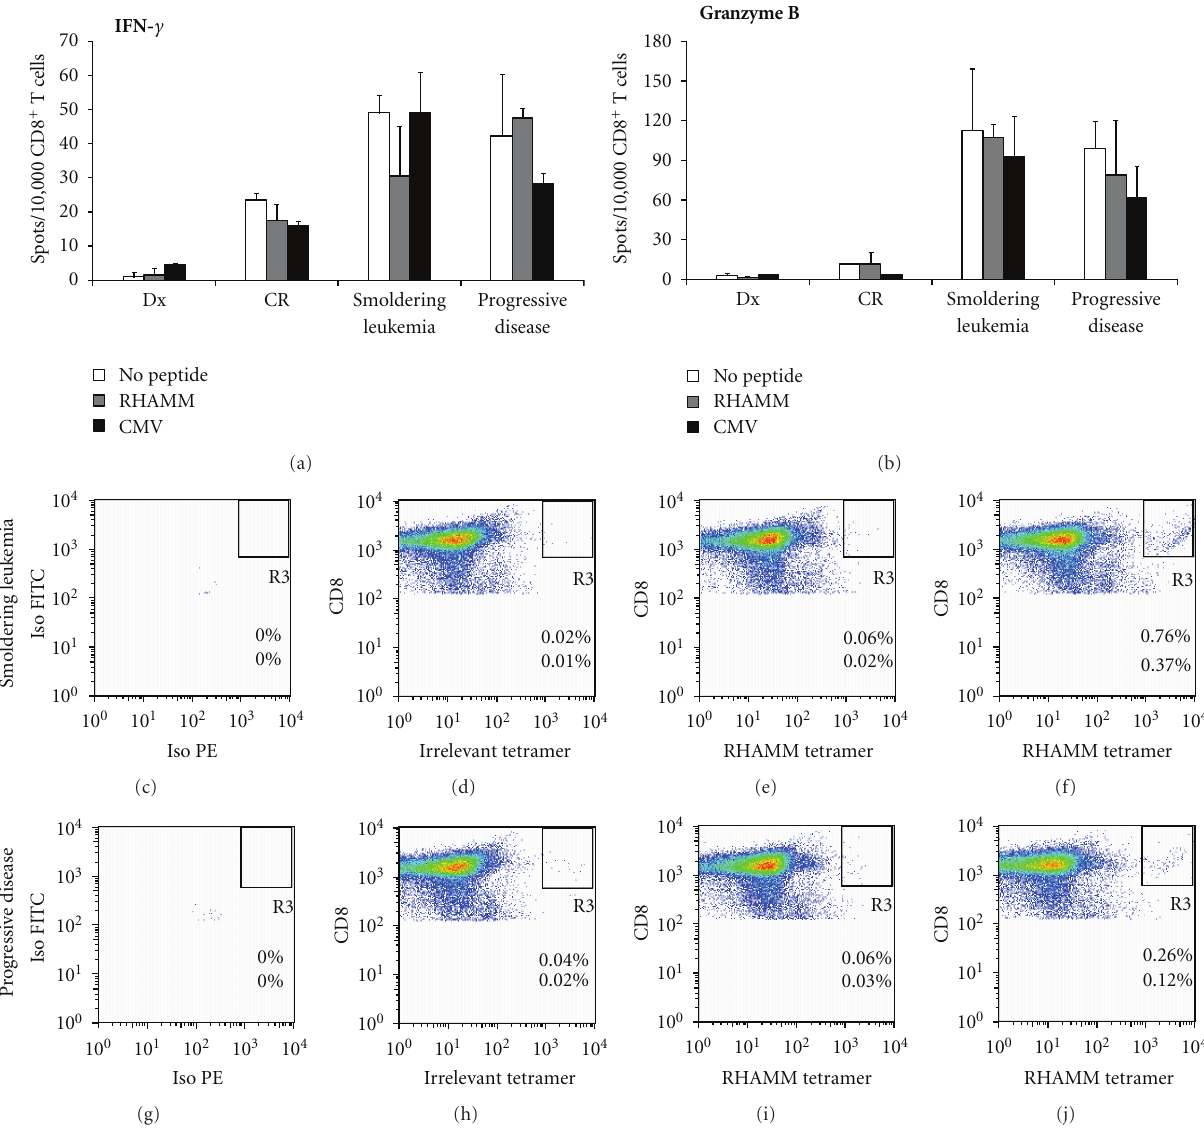
Figure 4: RHAMM-specific CTLs are present, but not functional. PBMCs were obtained from an AML patient who received chemotherapy. (a), (b). RHAMM-specific CTLs detected by flow cytometry at the stage of smoldering leukemia (c)–(f) and at the stage of progressive disease (g)–(j) did not release neither IFN- γ (a), nor granzyme B (b) at a level higher than background (no peptide control) as assessed by ELISPOT assays. (c)–(j) Reported frequencies correspond to all cells in the CD3 + CD8 + T-cell gate (upper numbers), and to all cells in the lymphocyte gate (lower numbers). (c), (g) Isotype negative control, (d), (h) Non-peptide negative control, stained with an irrelevant tetramer, (e), (i) Non-peptide negative control, stained with RHAMM tetramer, (f), (j) CD8 + T cells were stimulated with RHAMM peptide and stained with RHAMM